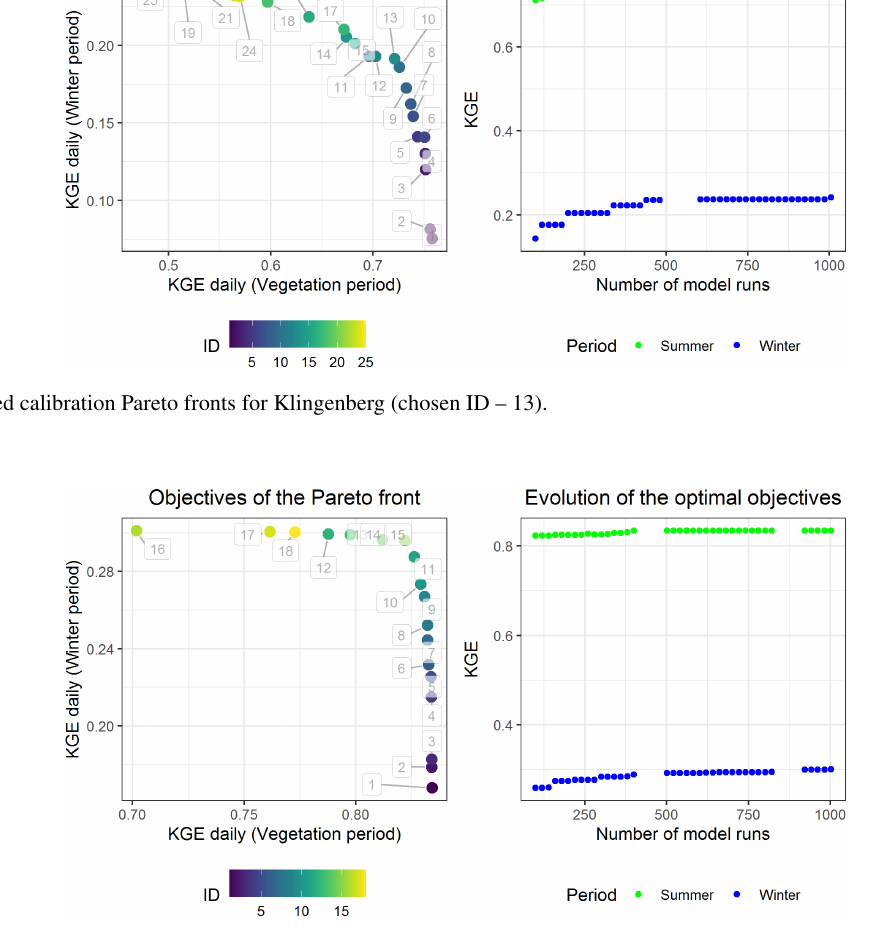
https://doi.org/10.5194/hess-26-3177-2022 Hydrol. Earth Syst. Sci., 26, 3177–3239,